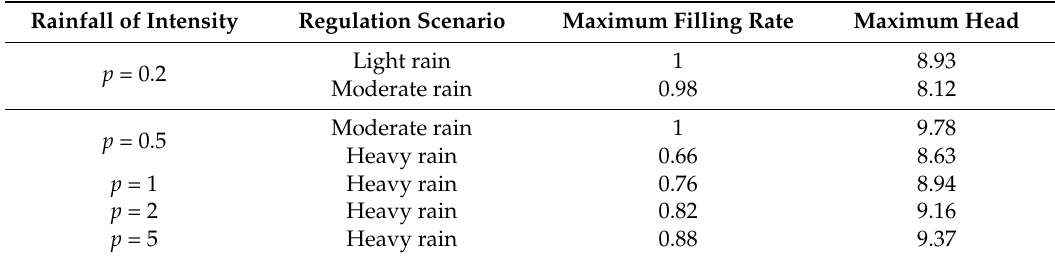
Table 4. Maximum filling rate of the deep tunnel drainage system and maximum head of the upstream sewage interception sluice gate of DongHaoChong (SISGD) for rainstorms with different design recurrence